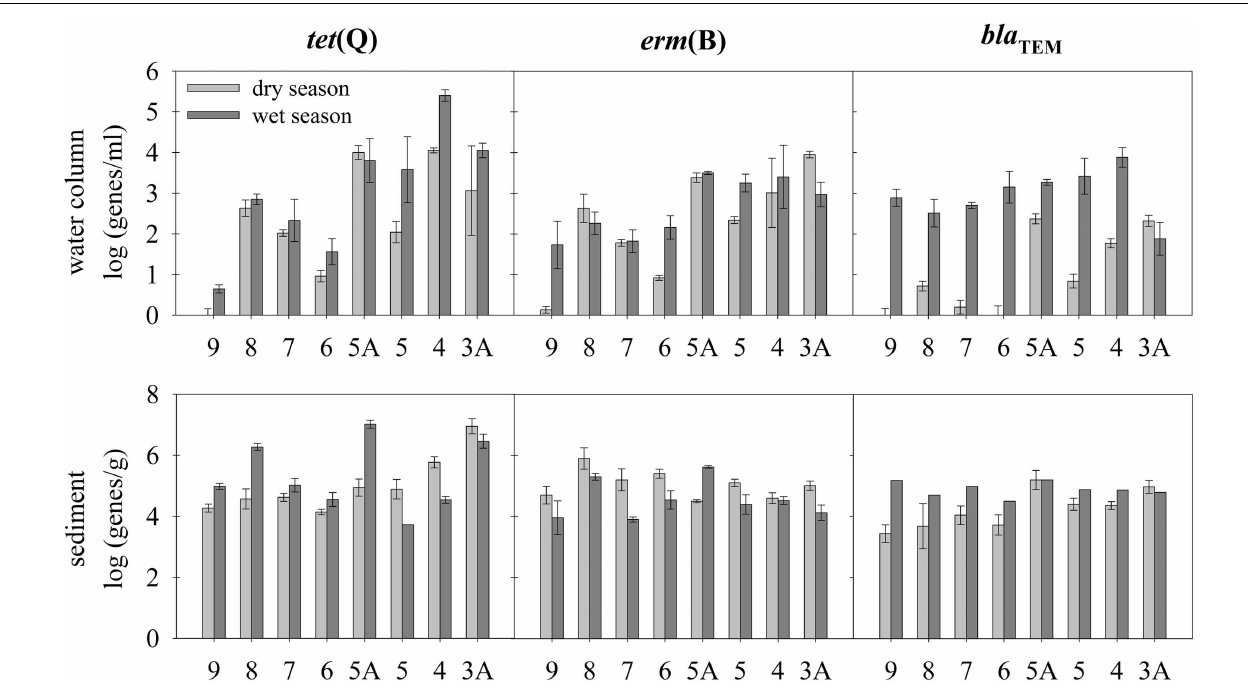
Frontiers in Microbiology | Antimicrobials, Resistance and